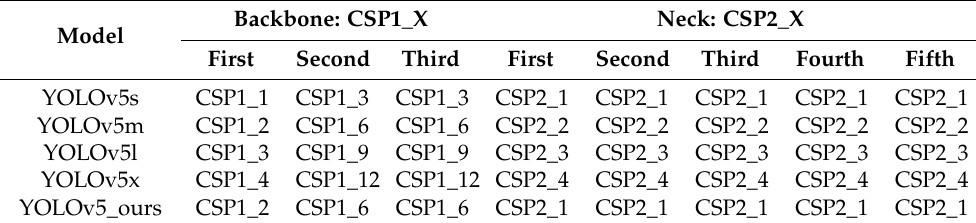
Table 3. Network depth comparison of different YOLOv5 models.